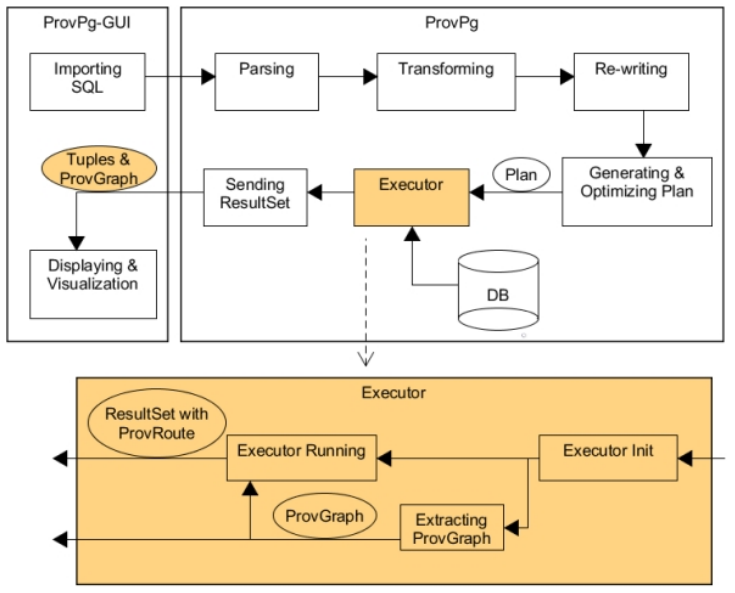
Figure 9. The architecture of Provpg.